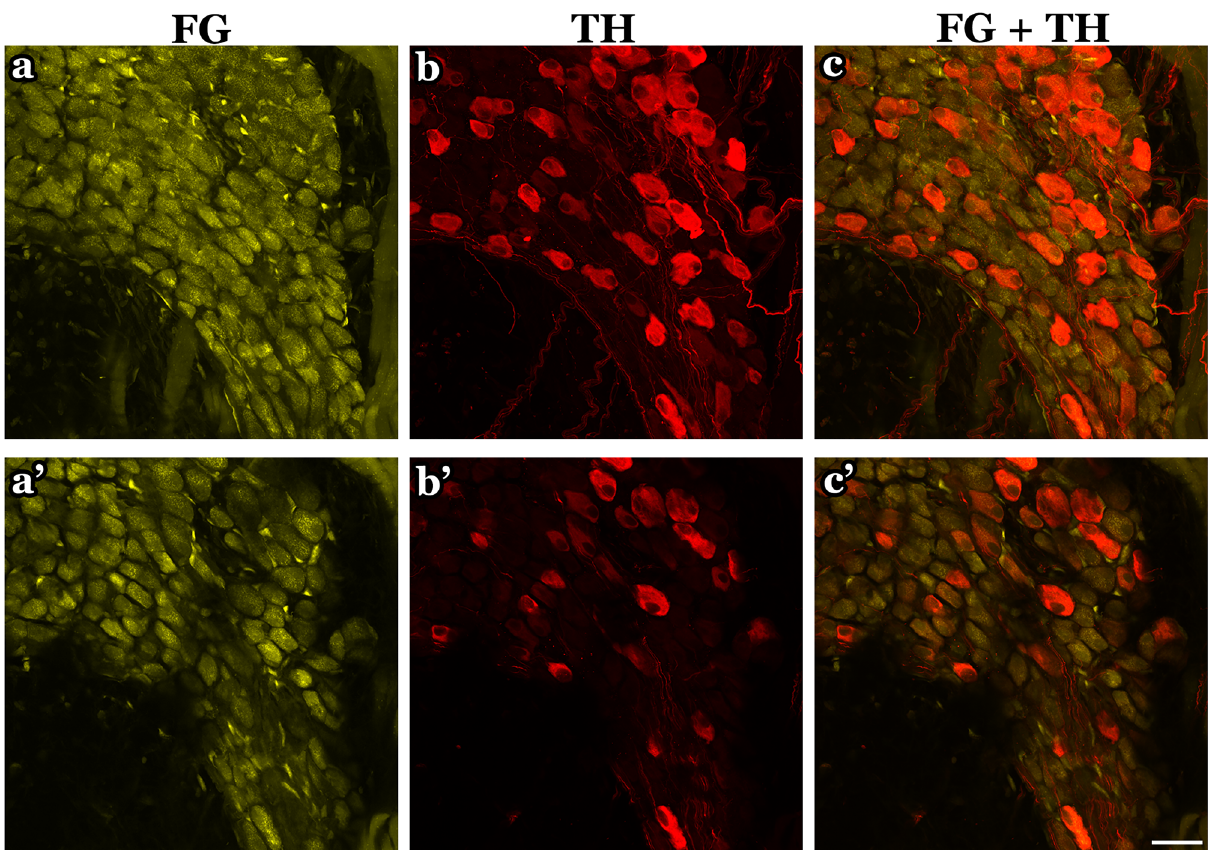
Figure 10. ICG contained a subpopulation of TH-IR neurons. ( a ) Partial projection confocal image of FG-labeled neurons (yellow) in the ICG located on the dorsal surface of the LA. ( b ) TH-IR neurons (red). ( c ) Merged image revealed TH-IR neurons relative to FG-labeled neurons and TH-IR axons passing through the ICG neurons. ( a’-c’ ) Single optical sections of the representative images ( a - c ). FG fluoro-gold, ICG intrinsic cardiac ganglia. Scale bar: 50